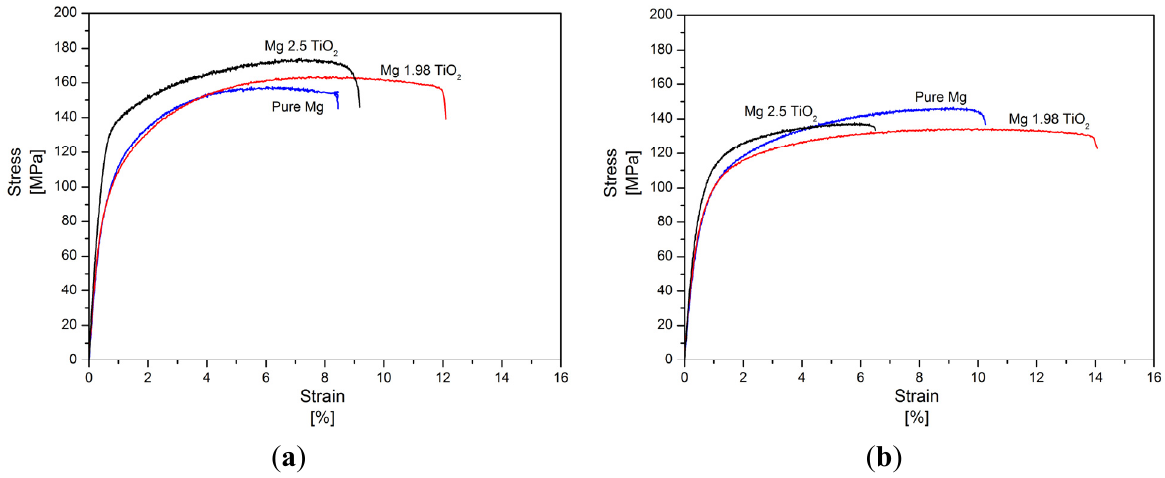
Figure 4. Stress–Strain curves of ( a ) DMD and ( b ) PM synthesized pure Mg and Mg-TiO 2